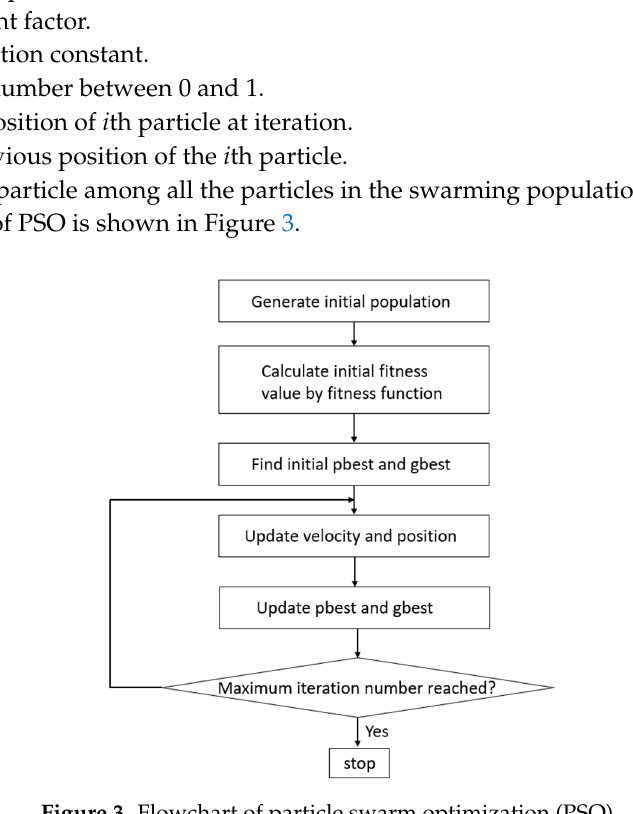
Figure 3. Flowchart of particle swarm optimization (PSO).